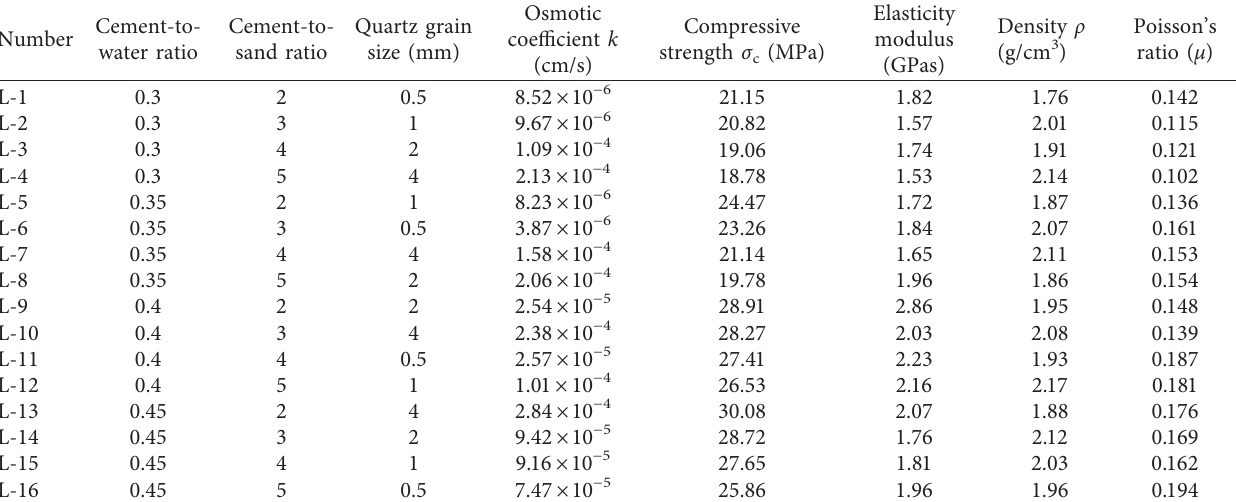
Table 2: Physical and mechanical parameters of quasi-conglomerate similar material.